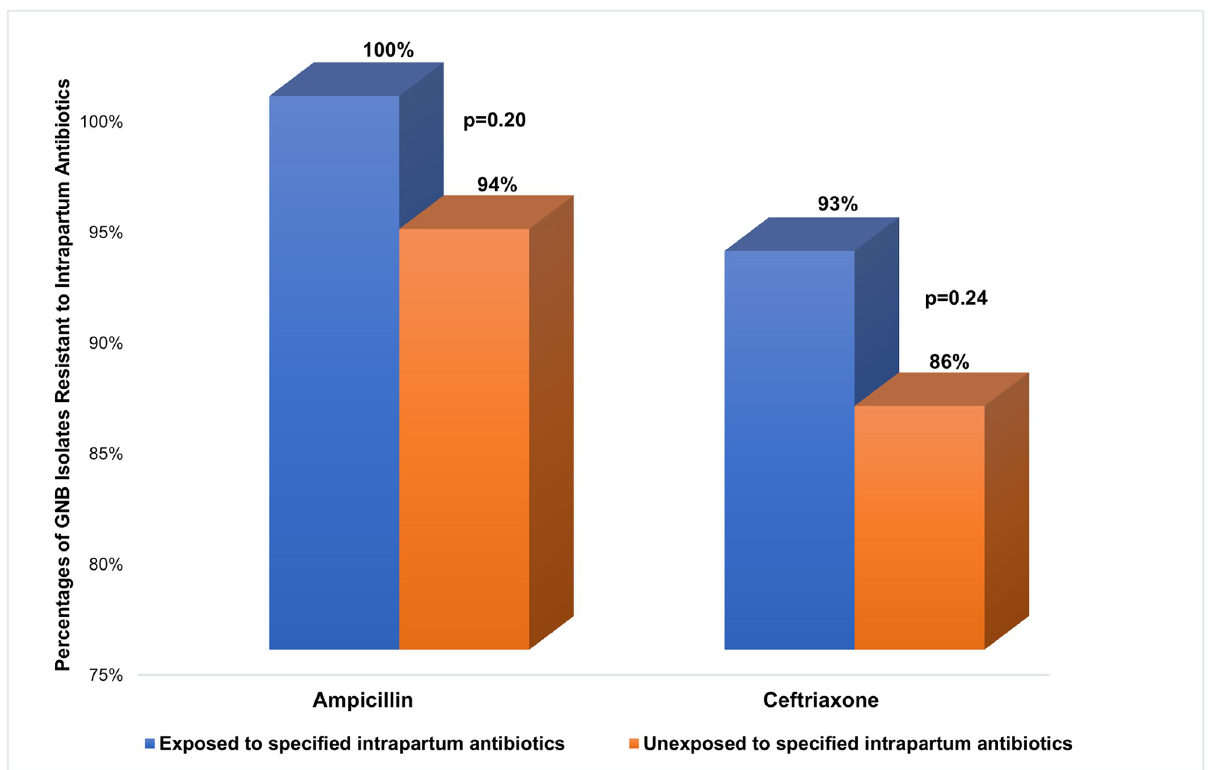
Fig 13. Intrapartum antibiotics and single-drug resistance. Ampicillin-resistance was 100% among newborns exposed to intrapartum ampicillin compared to 94% among the unexposed (p = 0.20) while ceftriaxone-resistance was 93% among newborns exposed to intrapartum ceftriaxone compared to 86% among the unexposed (p =